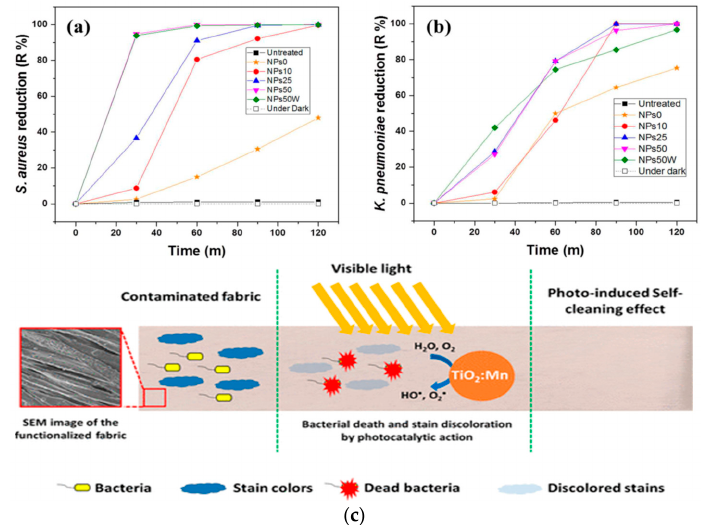
Figure 32. Bacterial reduction in percentage of ( a ) S. aureus and ( b ) K. pneumoniae on cotton fabrics with and without Mn-doped TiO 2 NPs in the dark and under natural sunlight. NPs0, NPs10, NPs25 and NPs50 are cotton fabrics with zero, 10, 25 and 50 wt% Mn-doped TiO 2 NPs; NPs50W is the NPS50 after 10 washing cycles. ( c ) Schematic of visible light induced the photocatalytic inactivation of bacteria and degradation of stain residues on contaminated fabric with Mn-doped TiO 2 NPs. Reproduced with permission from [298]. Copyright American Chemical Society, Table 2. Bactericidal performance of modified titania nanoparticles under visible light.